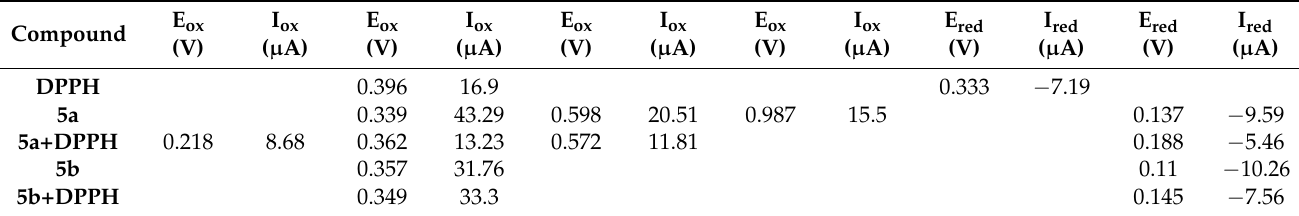
Table A2. Comparative presentation of the scavenging effect of the tested compounds and of some antioxidants on DPPH˙ Figure A5. Overlapped CVs for 0.5 mM DPPH ˙ (black); 0.5 mM solution of the synthesized compounds (blue) and of radical after 30 min of solutions with equal concentrations of 0.5 M of DPPH ˙ and one compound at a time (pink) prepared in 0.1 M HClO 4 on graphite SPE.